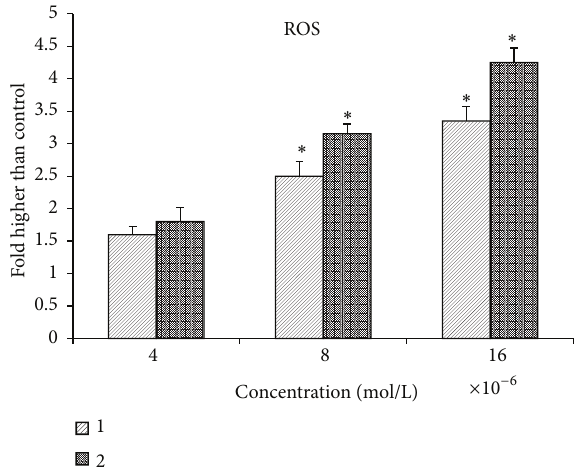
Figure 13: Effect of MMD compound on the generation of ROS. The level of ROS significantly elevated at 8 × 10 −6 and 16 × 10 −6 mol/L